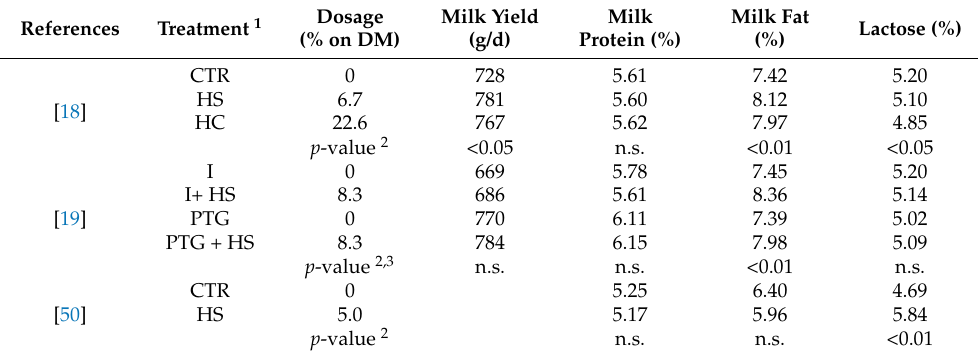
Table 5. Effect of hempseed and derivatives on the chemical composition of ewe milk.